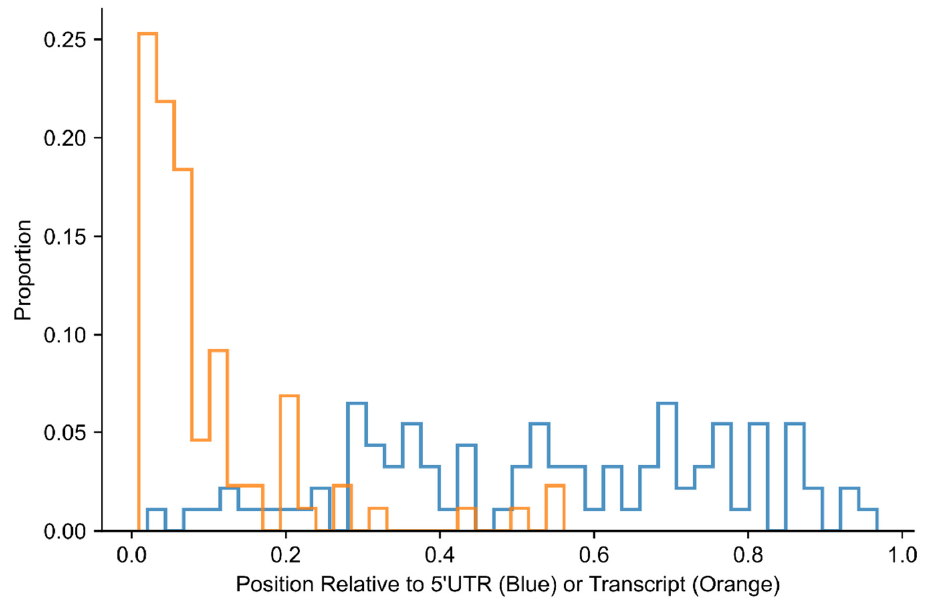
Figure 4. Position of upstream noncanonical TICs in the 5 ′ UTR (blue) and canonical TICs in the mRNA transcript (orange).